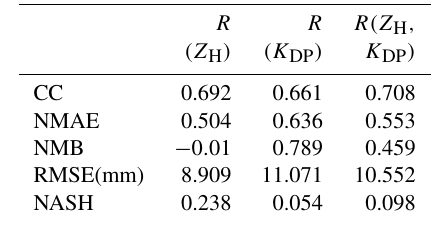
Table 6. Verification of the radar-based rainfall 24h accumulation products of Italy. Z H is not corrected for